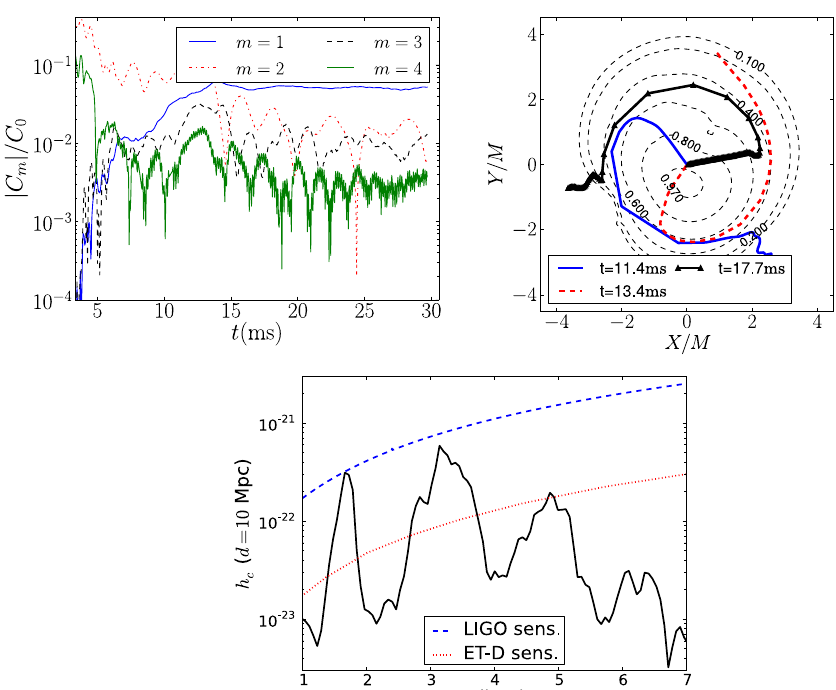
Fig. 37 Top left panel: Magnitude of C m normalized to C 0 as a function of coordinate time. Top right panel: Thick lines indicate the phase of the mode C 1 as a function of cylindrical radius (cid:14) at select times. Dashed thin lines are contours of the rest-mass density normalized to its maximum value at t = 13 . 4ms. The numbers inlined are the values of the level surfaces. The small contour at X / M ≈ Y / M ≈ 1 has a value of 0.6 and is at the cite of a strong vortex. Lower panel: gravitational wave characteristic strain (solid black curve) vs gravitational wave frequency for the last ∼ 15ms (after the m = 1 instability has saturated) seen by an observer located edge-on at r = 10 Mpc. The first peak on the left corresponds to the m = 1 mode. Notice that the frequencies of the peaks satisfy f m (cid:13) mf 1 , m = 1 ,... 4, with f 1 (cid:13) 1 . 7kHz. Dashed (blue) curve: the aLIGO sensitivity curve. Dotted red curve: the proposed Einstein Telescope (ET- D) sensitivity curve (Hild et al. 2011) (Image reproduced with permission from Paschalidis et al. 2015, copyright by